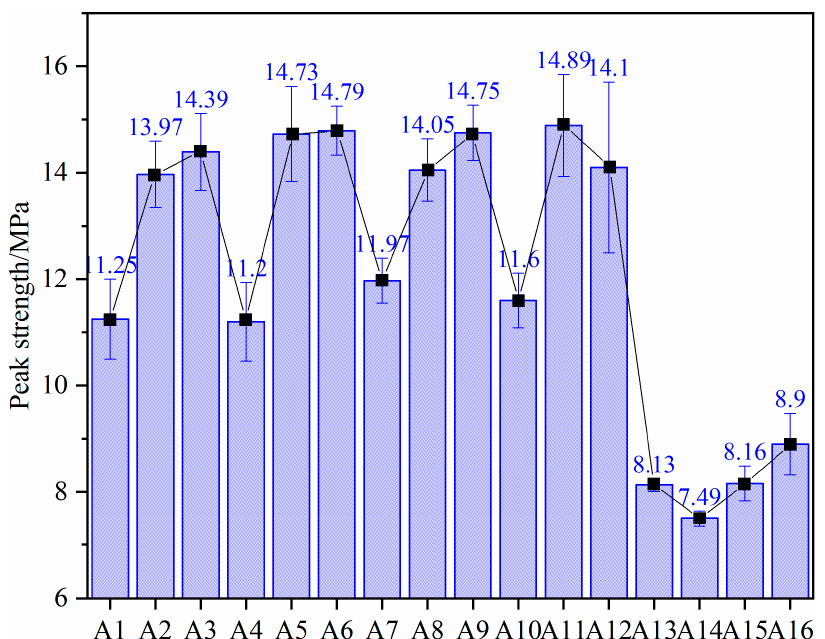
Figure 5. Peak strength of 16 experimental groups.